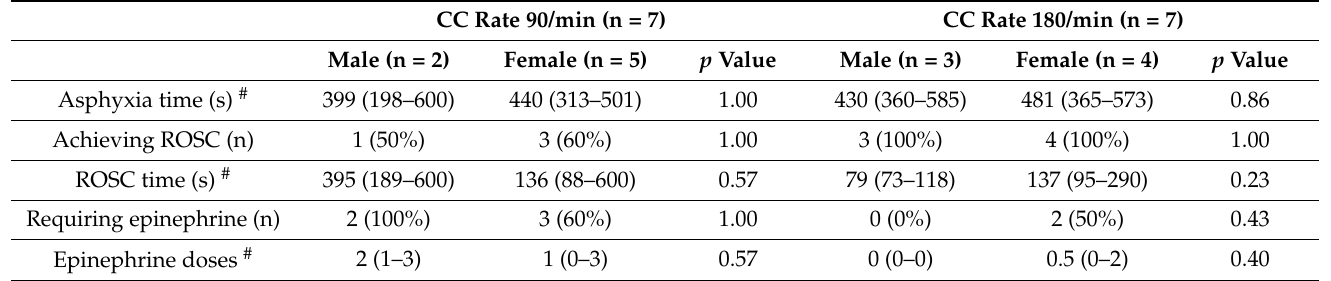
Table 3. Data separated by